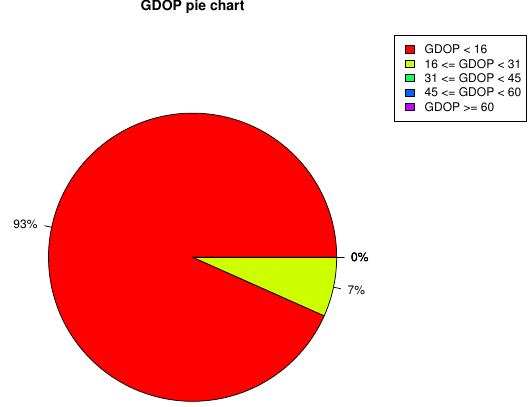
Figure 4. Simulated GDOP distribution of optimal placement of ADS-B sensors. The corresponding k coverage heatmap is given in Figure 3.